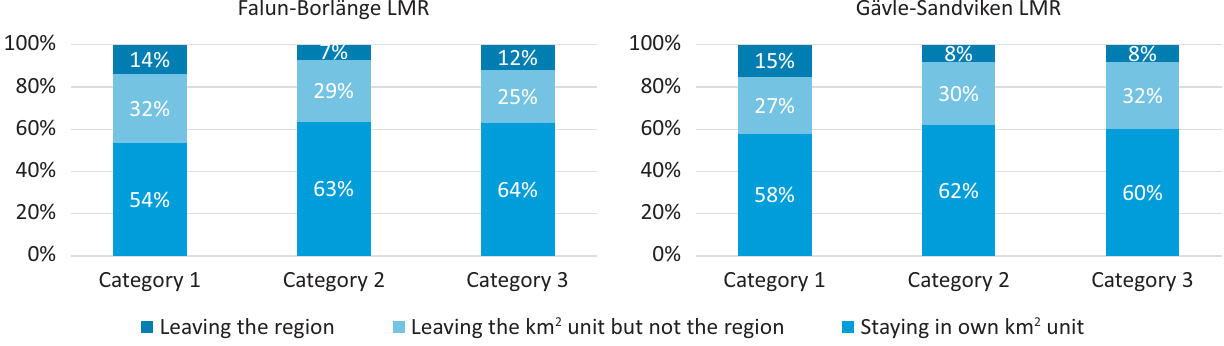
Figure 2. Share of phones staying within their own km 2 , leaving their own km 2 , and leaving the region: Falun-Borlänge (left) and Gävle-Sandviken (right). Note: Data from 28 March 2019, Thursday. The share of stayers is higher in areas where the share of non-Europeans is at or above the mean. However, results are only valid for Thursdays. For Saturdays, the ethnic composition is insignificant.